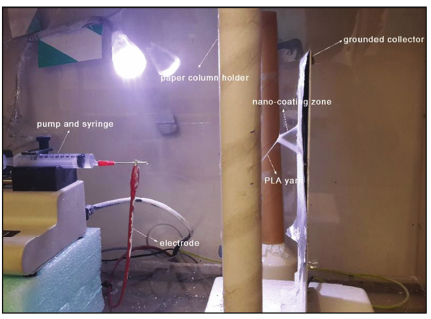
Figure 1: Nanocoating on the PLA yarn by